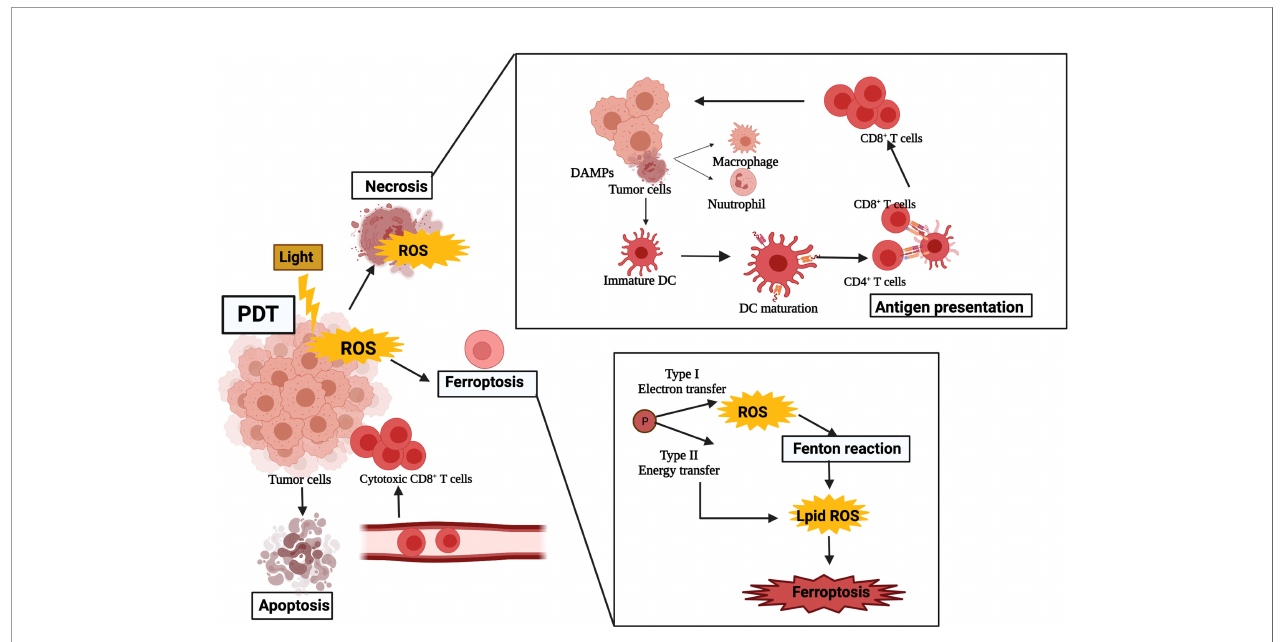
FIGURE 2 | The stimulation of photodynamic therapy on the immune system after treatment. The ROS can cause damage to tumor cells and lead to the release of DAMPs, which, in turn, activate host immune cells such as neutrophils, dendritic cells, and macrophages. Immature dendritic cells in fi ltrating peripheral tissues engulfed apoptotic tumor cells and oxidatively damaged cells. DAMP, damage-associated molecular pattern; DC, dendritic cell; ROS, reactive oxygen